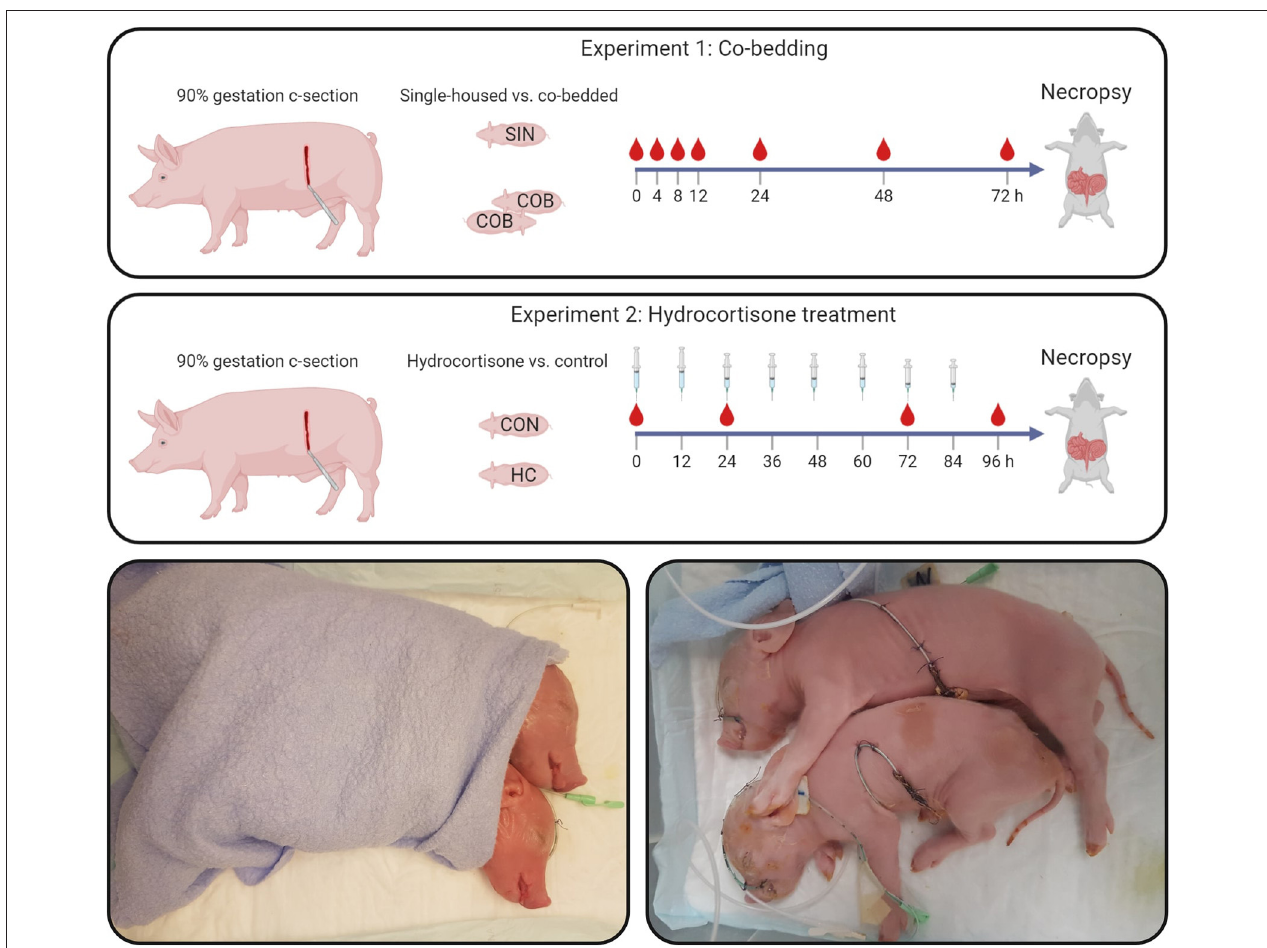
FIGURE 1 | Study design (upper panels). In Experiment 1, single-housed (SIN) and co-bedded (COB) Preterm cesarean-delivered piglets were studied for 72h, including a period of longitudinal monitoring of vital functions and blood gases. In Experiment 2, Preterm pigs receiving a tapering dose of hydrocortisone (HC) were compared with controls (CON) for 96h. Main outcomes in both experiments were vital signs, cardiovascular and respiratory functions, as well as gut structure and function, including NEC-like lesions. Lower panels show how co-bedded piglet siblings were wrapped together just after birth and fitted with umbilical catheters and feeding